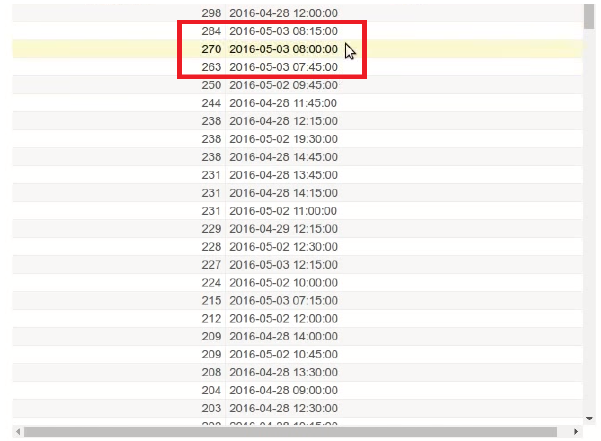
Figure 15. Rank of 15 min intervals with more unregistrations.